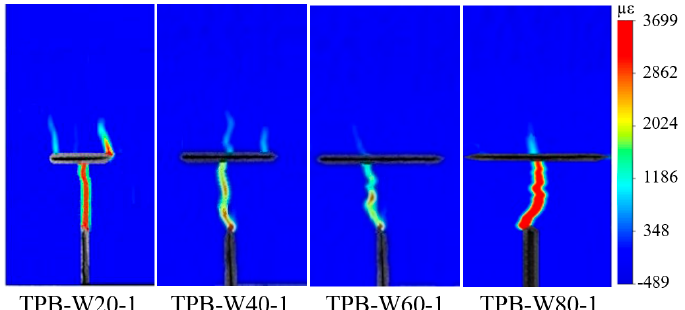
Figure 10. Strain contours in the computational domain on the beams with different preset crack lengths.